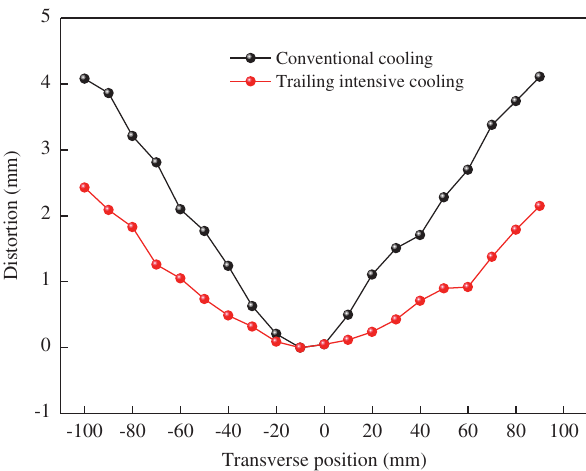
Figure 13: Distortion comparisons in experimental